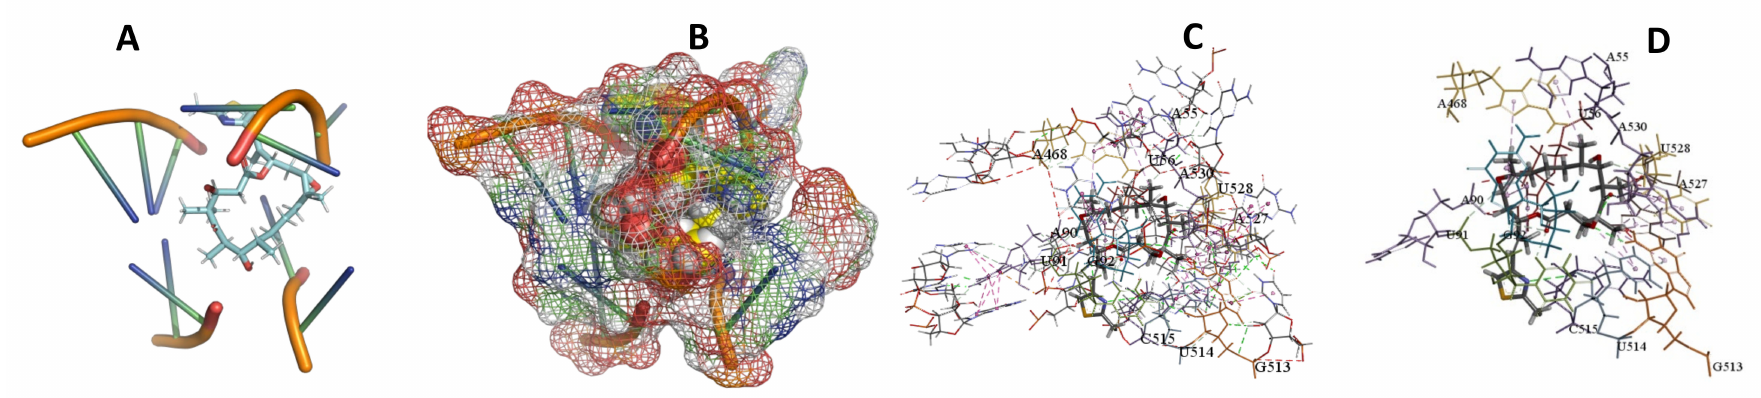
Figure 19. T. Brucei + Epothilone. ( A ): Best binding pose and nucleotides involved. ( B ): Schematic binding pocket. ( C ): shows the Nucleotides component that re involved in binding. ( D ): Shows the main bonds involved between the compound and the nucleotide